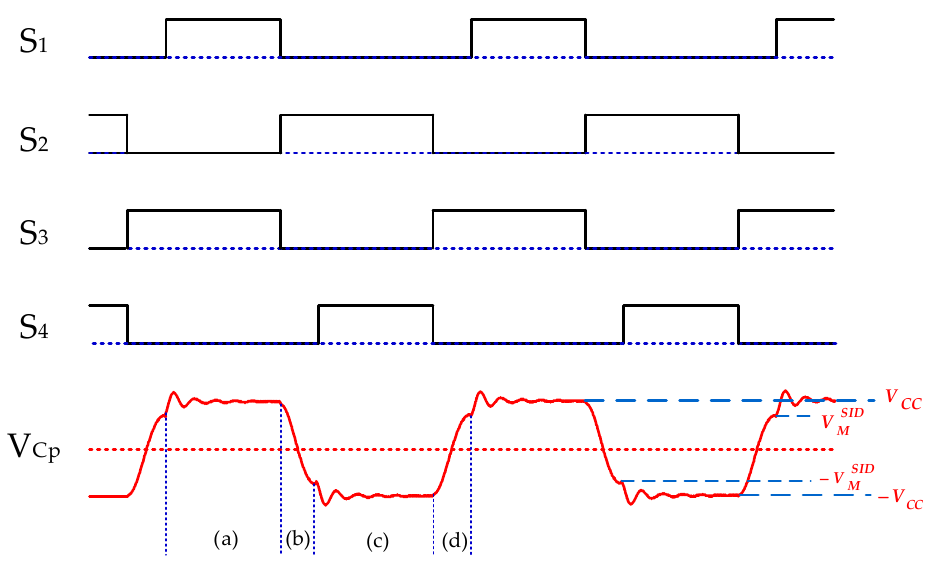
Figure 7. Switching waveforms of the SID circuit. Figure 8 shows the driving process of the SID circuit, where a cycle consists of four stages, corresponding to (a–d) in the Vcp waveform in Figure 7 and starting with all switches turned off. As shown in Figure 8a, the microcontroller outputs high-level signals to Q5 and Q4, resulting in the turn-on of Q5, Q1, and Q4. The current flows along with Vcc, Q1, L, PZT, and Q4, causing PZT to charge positively. In Figure 8b, only S2 outputs a high level to Q2 to turn Q2 on, so PZT, L, Q2, and the body diode inside Q4 form a reverse charging loop shown by the green circle. In this stage, the inductor charges the PZT. Similarly, in Figure 8c, the PZT is charged in the reverse direction and then charged in the forward direction by the inductor as shown in Figure 8d.